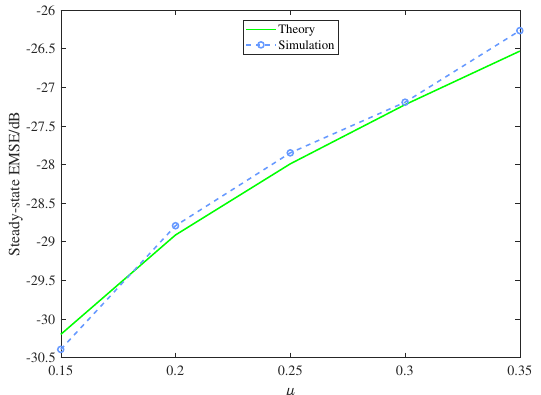
Figure 3. Theoretical and simulated steady-state EMSEs with different step